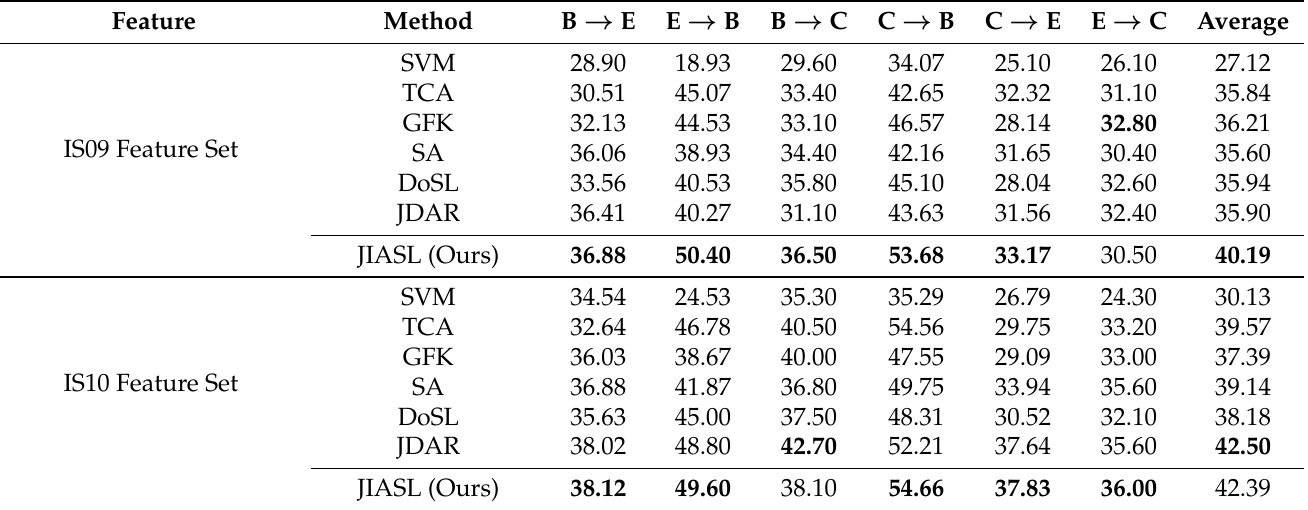
Table 2. The experimental results in terms of WAR (%) for six designed cross-corpus SER tasks. The best result in each task is highlighted in bold.